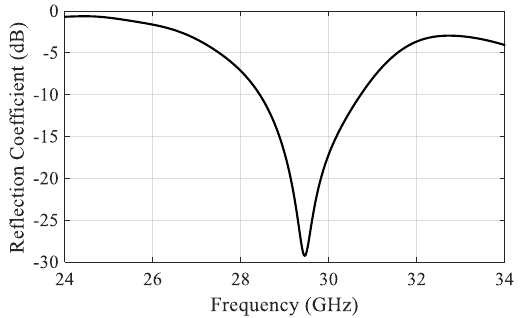
Figure 9. Reflection coefficient versus frequency of the antenna array, including ENZ metamaterial slabs.